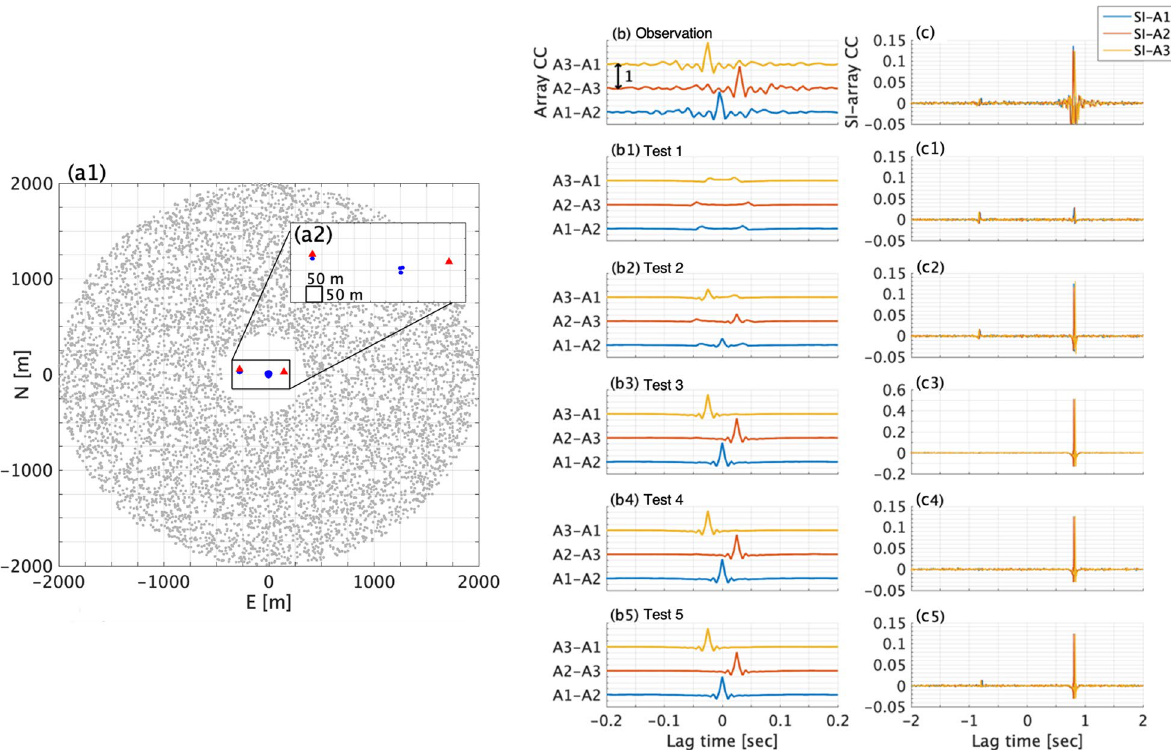
Fig. 4 The correlation peaks generated by ambient noise (correlation responses). a1 The locations of the microphones (blue points), signal sources (red triangles), and ambient noise sources (gray dots). a2 An enlarged view of a1 . b , c The observed array CCs ( b ) and SI-array CCs ( c ). They are compared with the synthetic array CCs ( b1 – b5 ; the vertical scales are identical to that of b ) and SI-array CCs ( c1 – c5 ). The numbers 1–5 indicate the